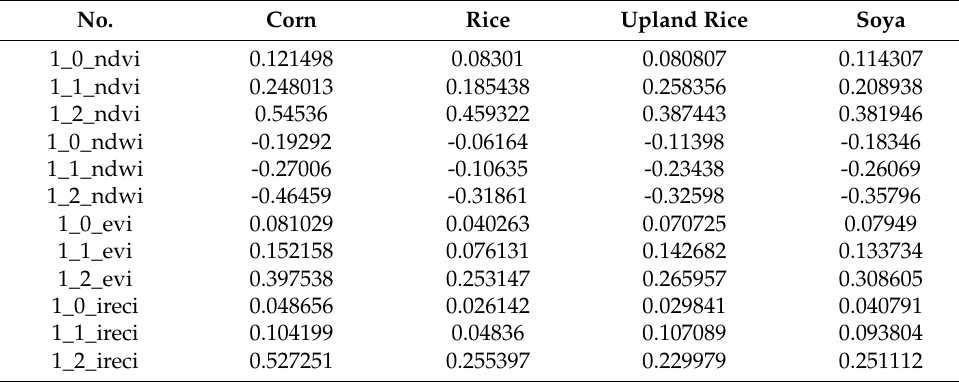
Table 4. Time series statistics of the spectral